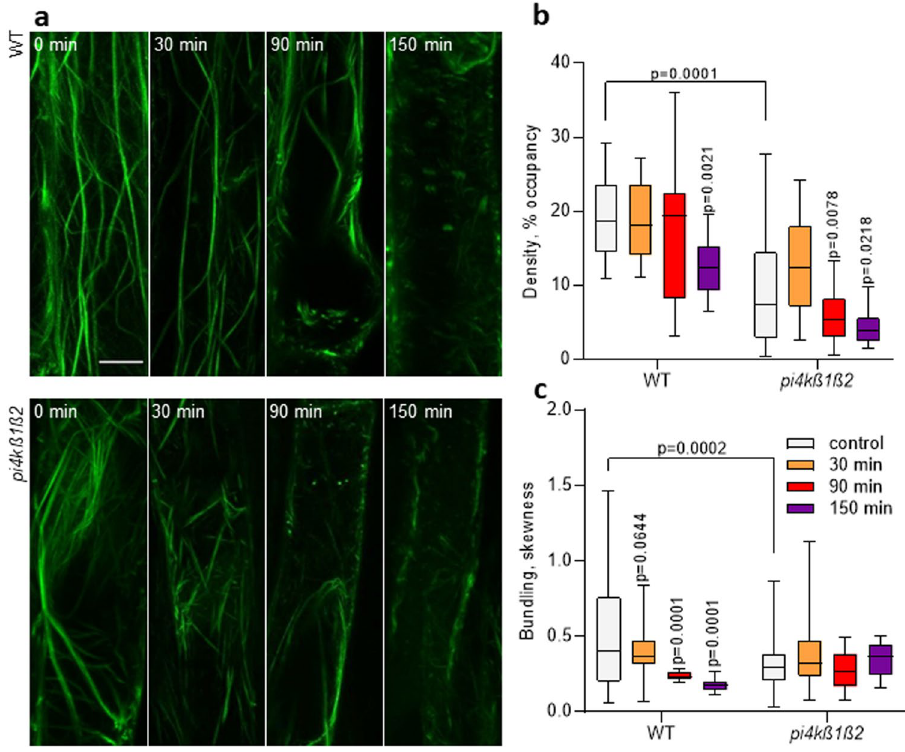
Figure 6. Actin reorganization in the pi4kß1ß2 mutant in response to latrunculin B. Five-day-old seedlings expressing 35S::LifeAct-GFP were sprayed with 10 µM latB. ( a ) representative maximum intensity projections of root epidermis of WT and pi4kß1ß2 plants; confocal microscopy, scale bar = 10 μm; ( b ) quantitative analysis of the density (expressed as percentage of occupancy) of actin filament arrays in epidermal cells; ( c ) quantitative analysis of the extent of filament bundling (expressed as skewness) in epidermal cells. Central line of the boxplots represents the median, plus represents the mean; circles represent individual values; p -value is indicated for significantly different time points within each genotype and for the comparison of genotypes immediately after treatment; one-way ANOVA with Tukey HSD post-hoc test; n =